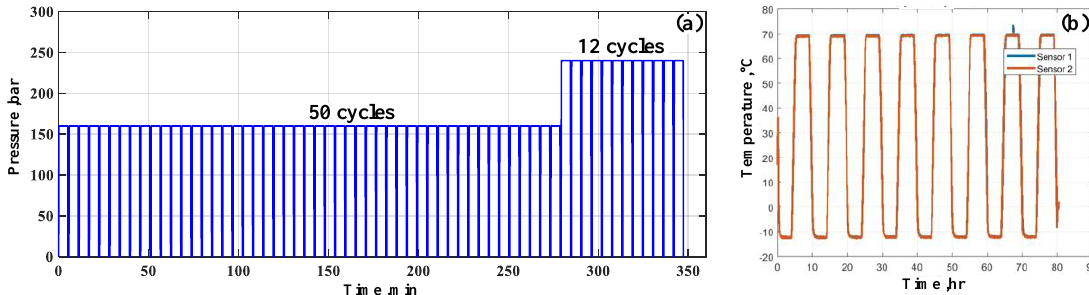
Figure 7. Figures showing ( a ) the pressure cycling test and ( b ) temperature cycling test, as part of the propellant tank qualification procedure.